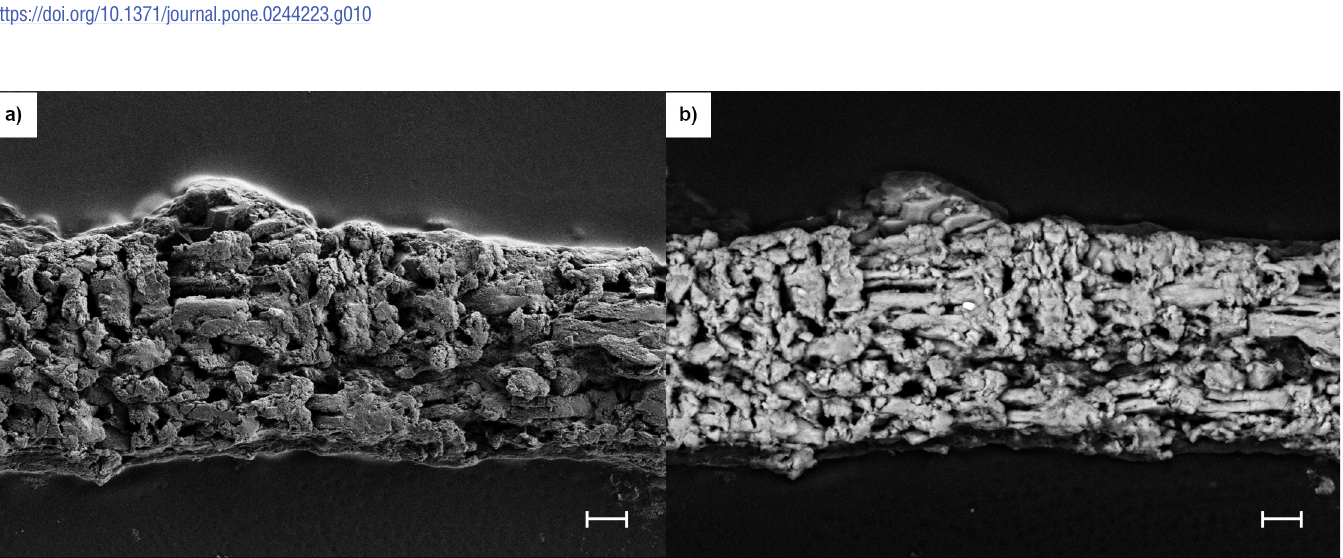
Fig 11. SEM secondary (a) and backscattered (b) electron images from a Daily PEMF ring construct frozen section at Day 63. SEM settings for (a): EHT = 3KeV, WD = 4.7 mm, H = 128.3 μ m, W = 171.0 μ m. Scale Bar = 10 μ m. SEM settings for (b): EHT = 15KeV, WD = 10.7 mm, H = 128.3 μ m, W = 171.0 μ m. Scale Bar = 10 μ m.